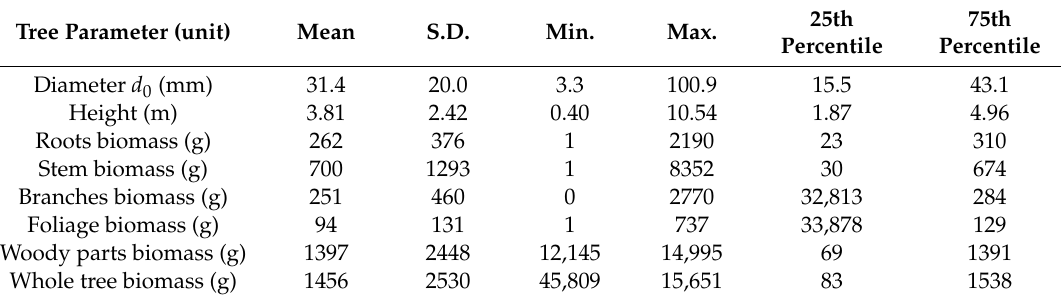
Table 4. Statistical characteristics of leaf traits of the sampled common aspen trees. Leaf Trait